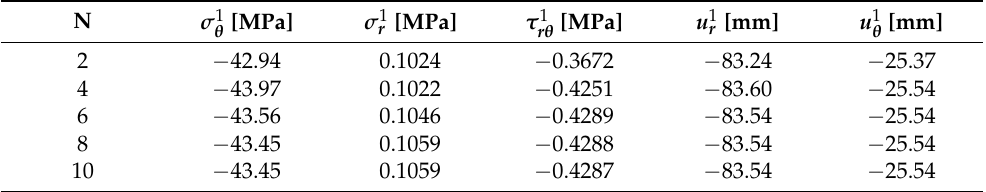
Table 1. The stresses and displacements of the solution here with different series terms.